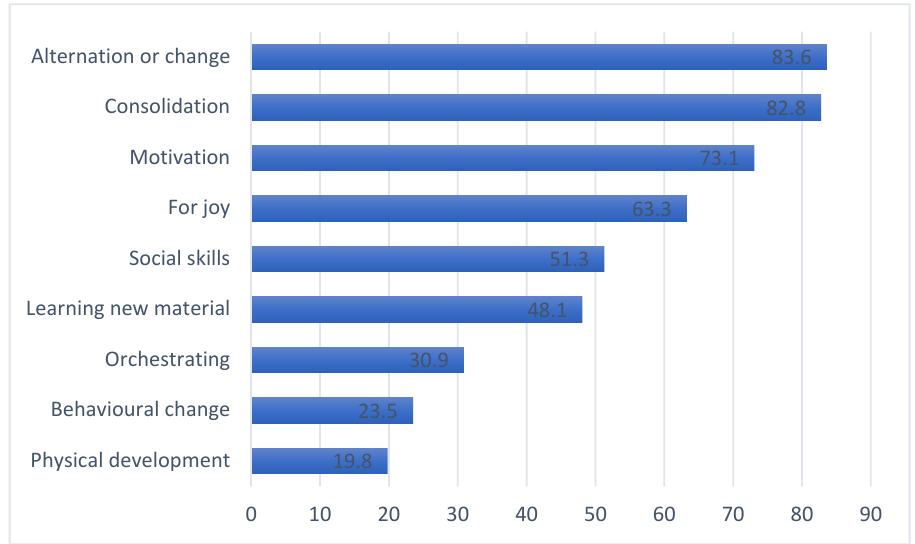
Figure 3. Reasons for teachers to use games, percentage in respondents N = 1258.